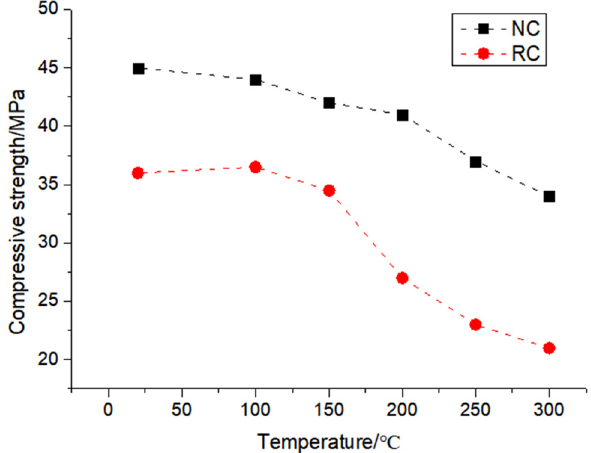
Figure 3: Compressive strength after high